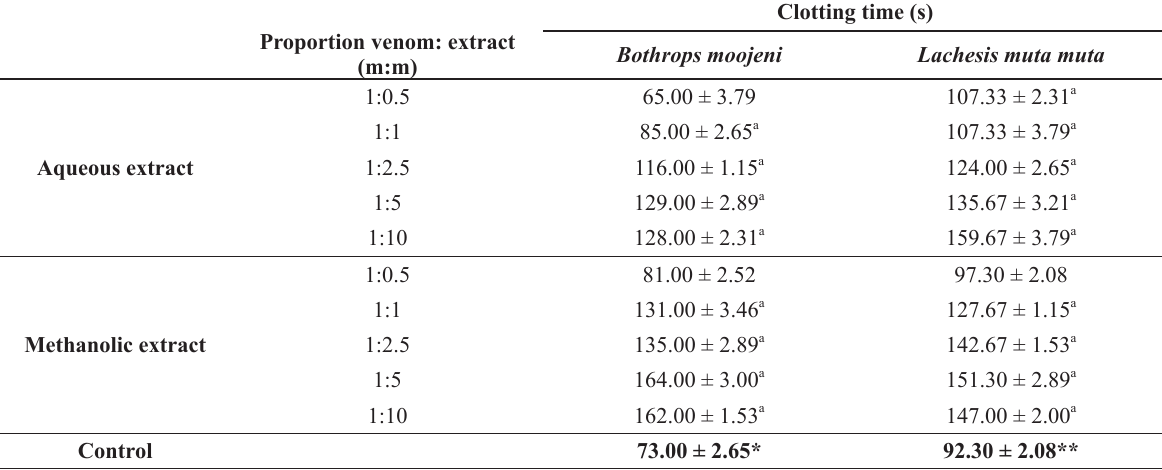
Effect of extracts of jabuticaba skin flour on the coagulant activity induced by different snake